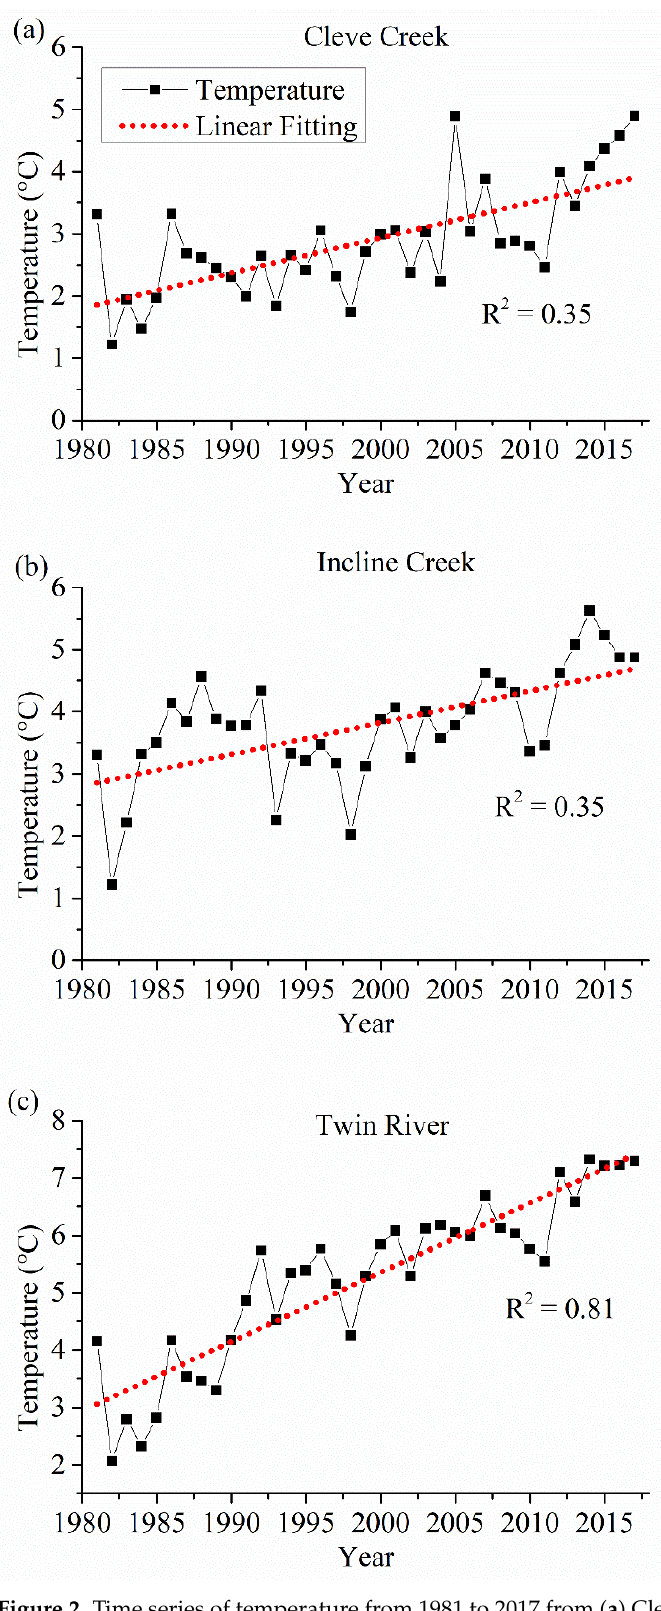
Figure 2. Time series of temperature from 1981 to 2017 from ( a ) Cleve Creek watershed, ( b ) Incline Creek watershed and ( c ) Twin River watershed.